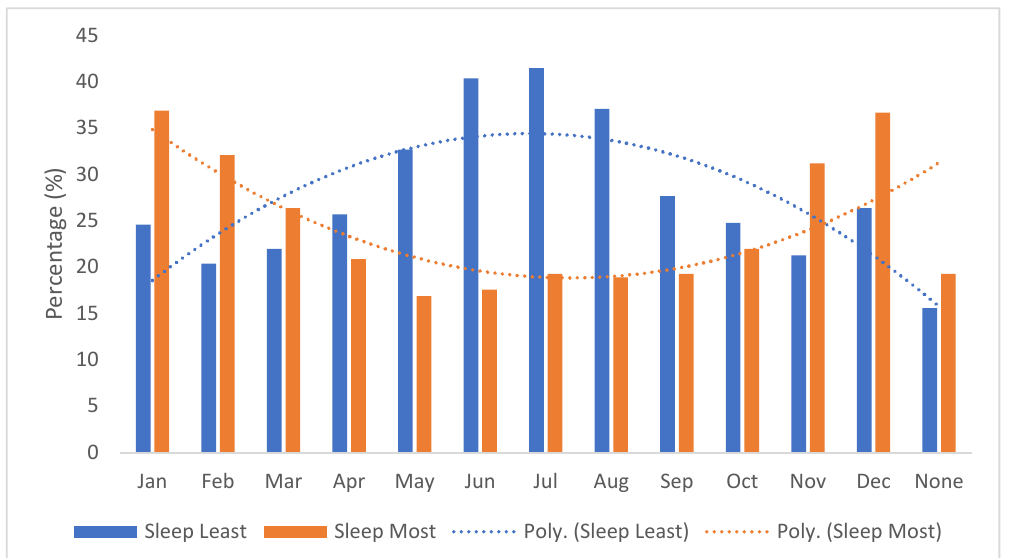
Figure 2. Percentage of time of the year of sleeping least and most ( n = 455).